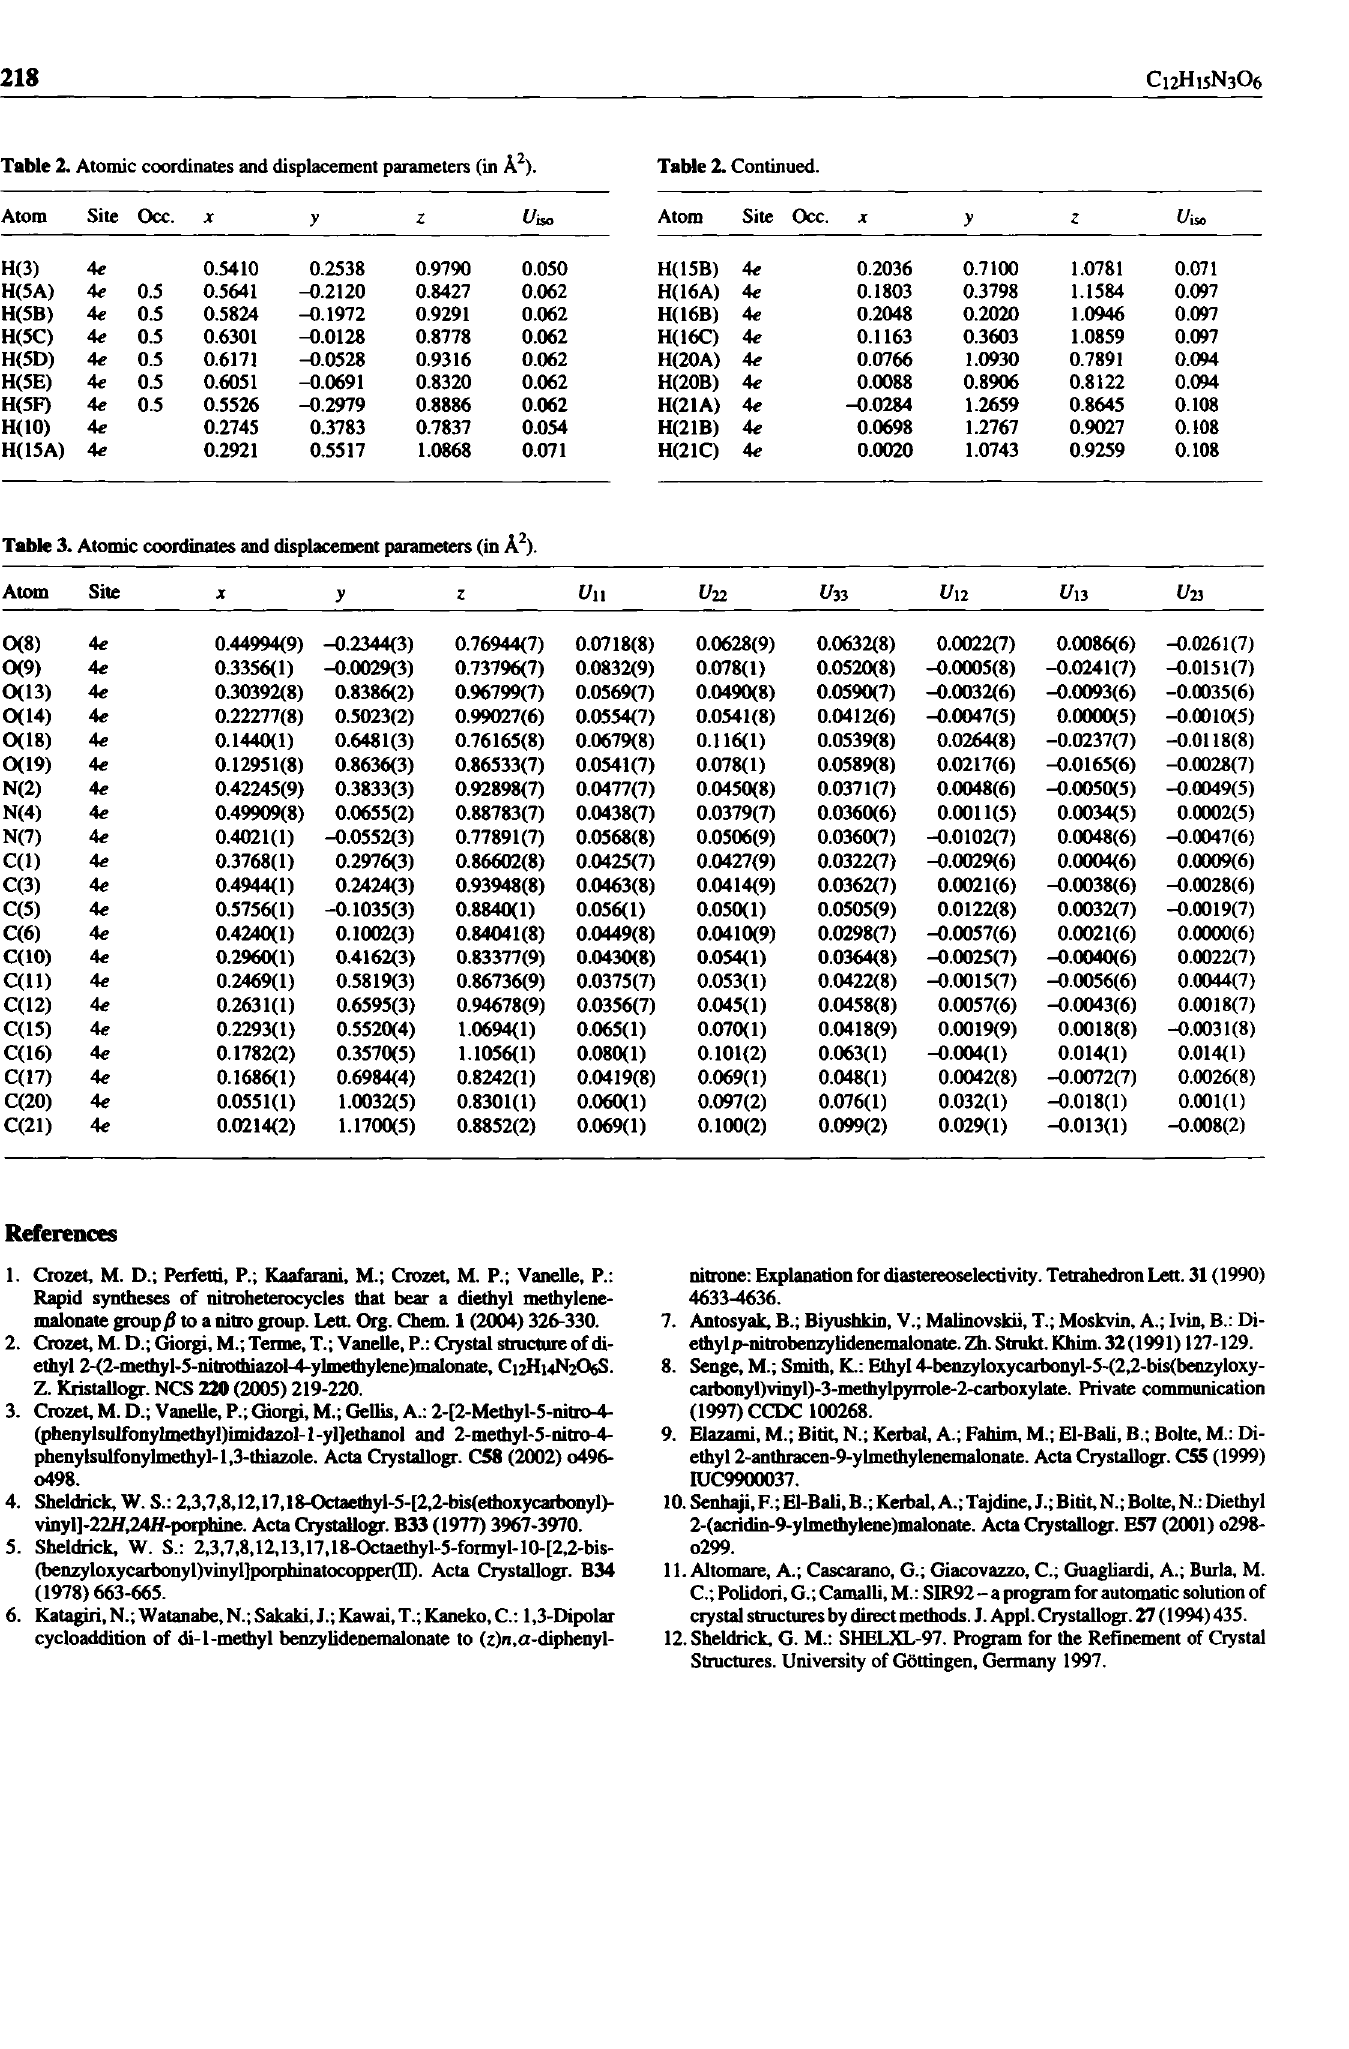
Table 2. Atomic coordinates and displacement parameters (in A 2 ).